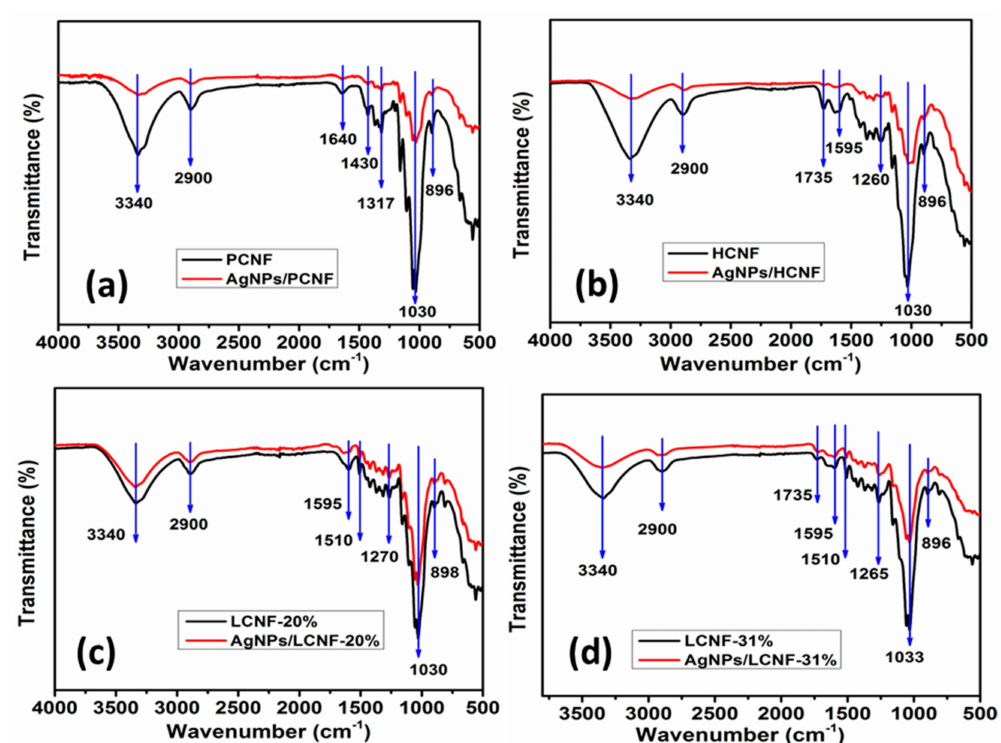
Figure 4. Comparison of FTIR spectra of the CNFs before and after the adsorption of AgNPs: ( a ) PCNF; ( b ) HCNF; ( c ) LCNF-20%; ( d ) LCNF-31% at the reaction temperature of 45 ◦